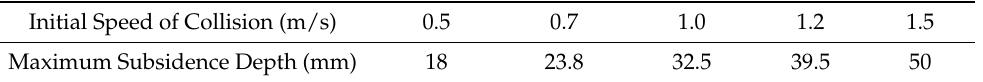
Table 4. The benthic lander’s maximum sinking depth at different bottom subsidence speeds.